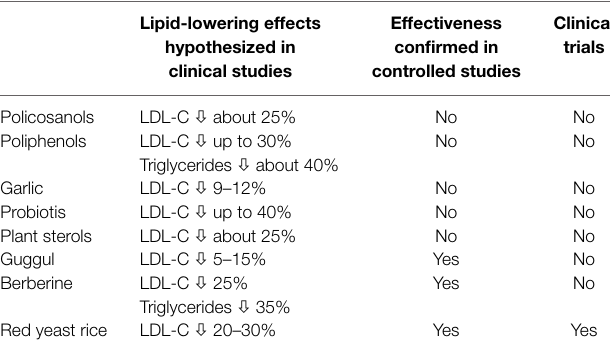
TABLE 2 | Summary of clinical data of different nutraceuticals with recommended lipid-lowering effect . Lipid-lowering effects hypothesized